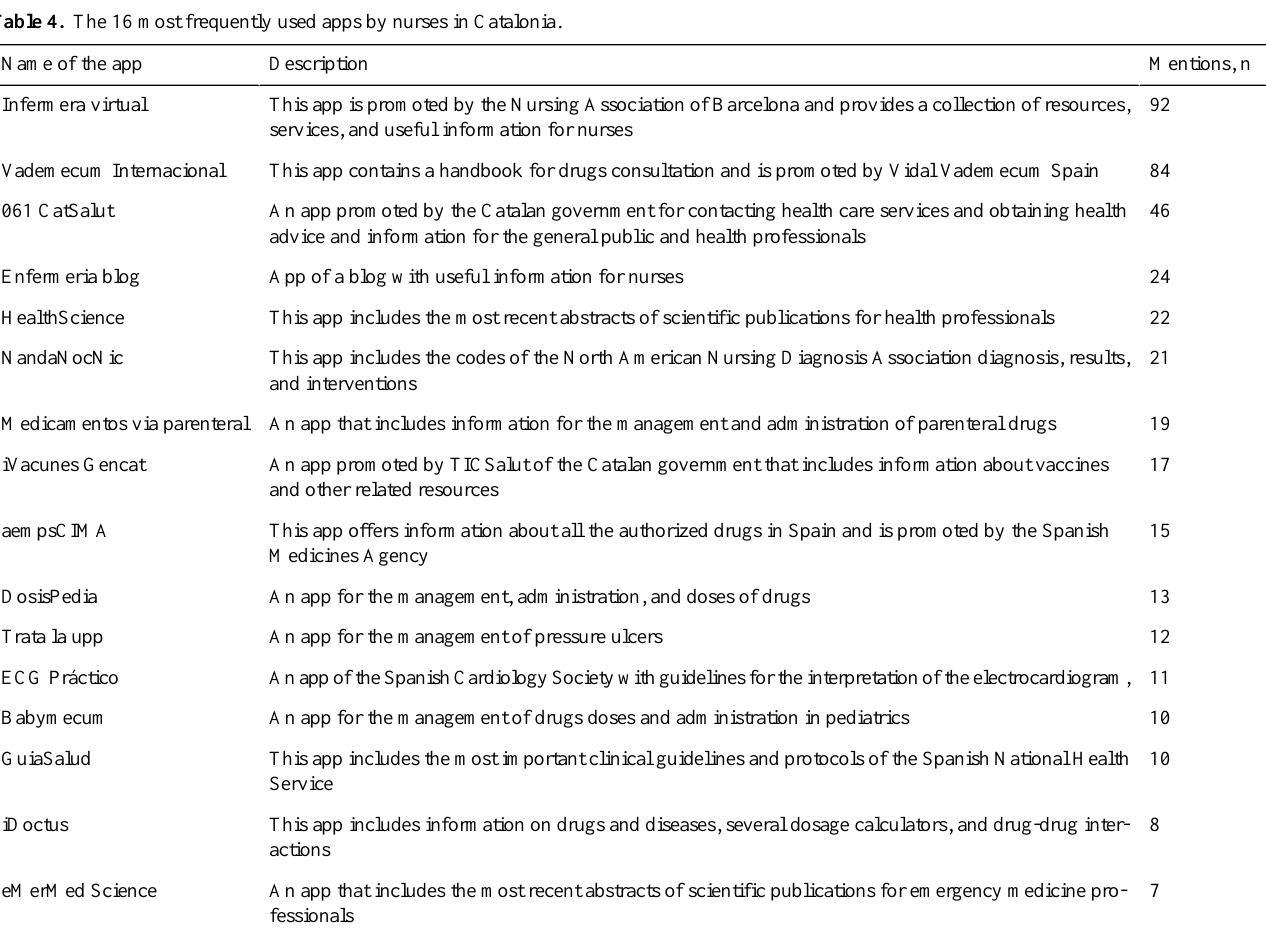
Table 4. The 16 most frequently used apps by nurses in